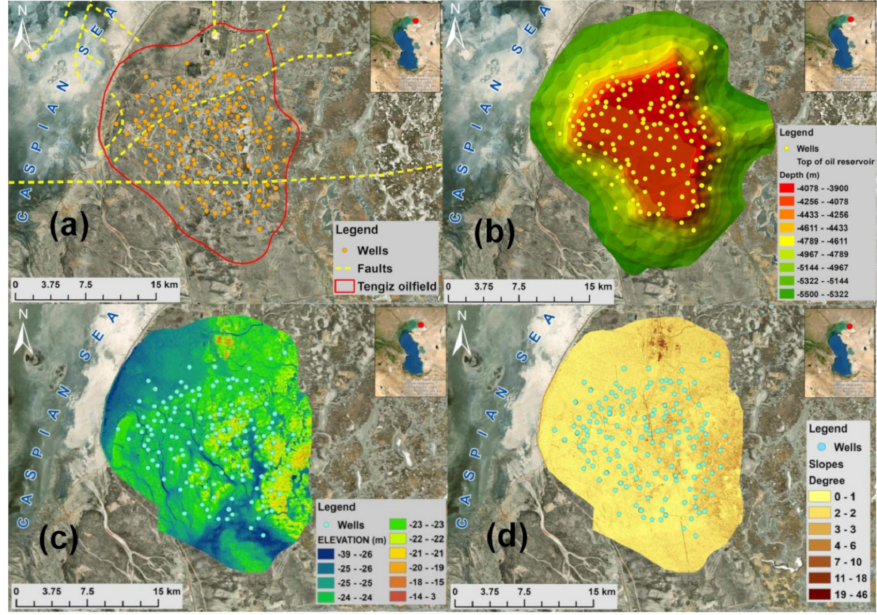
Figure 1. Tengiz oilfield: ( a ) representation of wells and faults; ( b ) top of the oil reservoir; ( c ) elevation; ( d )